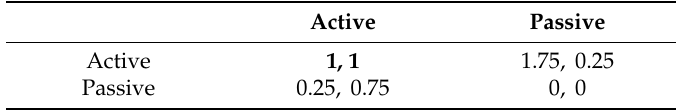
Table 13. Payo ff matrix A for 2 × 2 (Scrum Master vs. OTM) game for the most e ff ective team